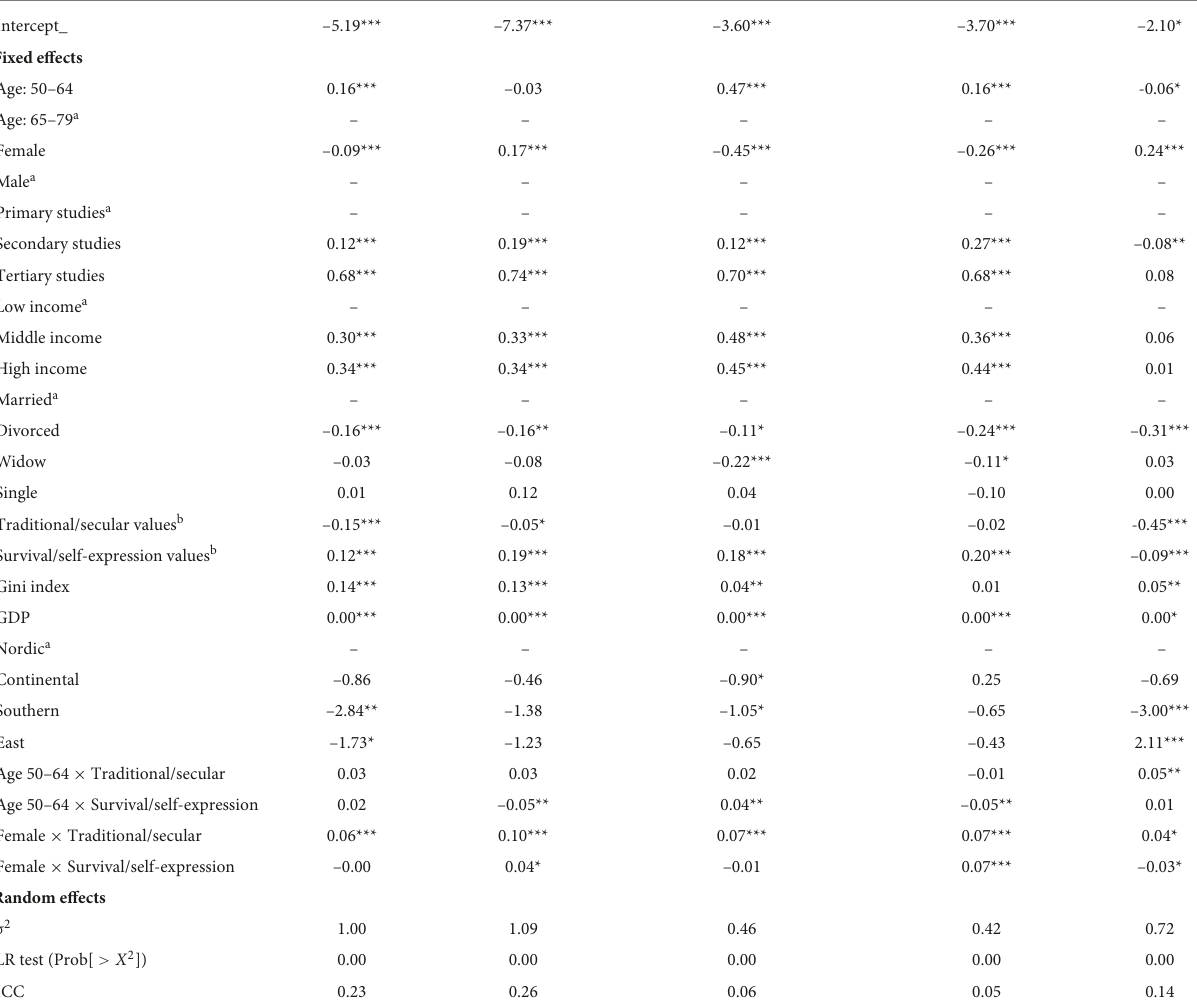
TABLE 4 Estimates of the moderating effect of values on volunteering: Model 3 by age and